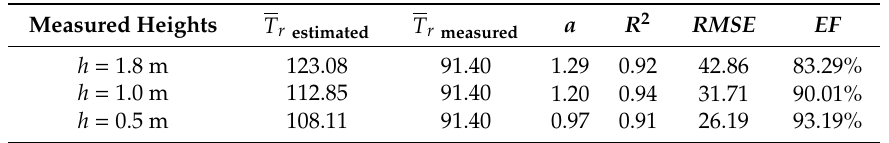
Note: T r estimated and T r measured were the averaged values of T r estimated by the SM and measured using a lysimeter (W m − 2 ), respectively; a is the slope of the least square regression line, R 2 is the coe ffi cient of determination, RMSE is the Root Mean Square Error (W m − 2 ), and EF is modeling e ffi